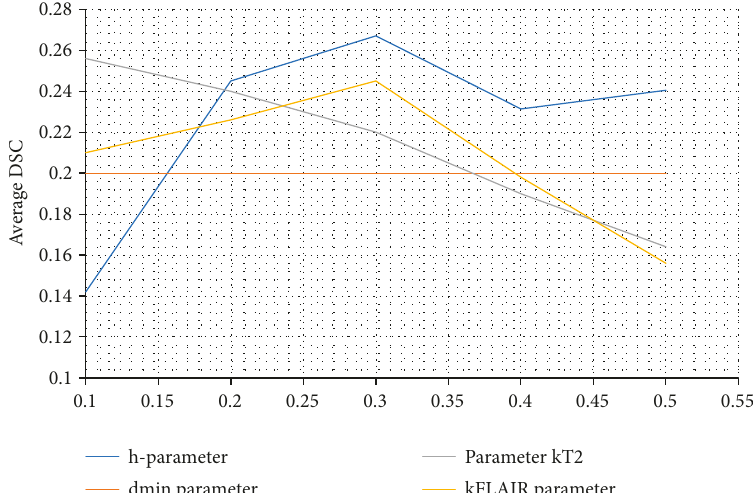
Figure 3: The results of the selection of parameters for the GMM.